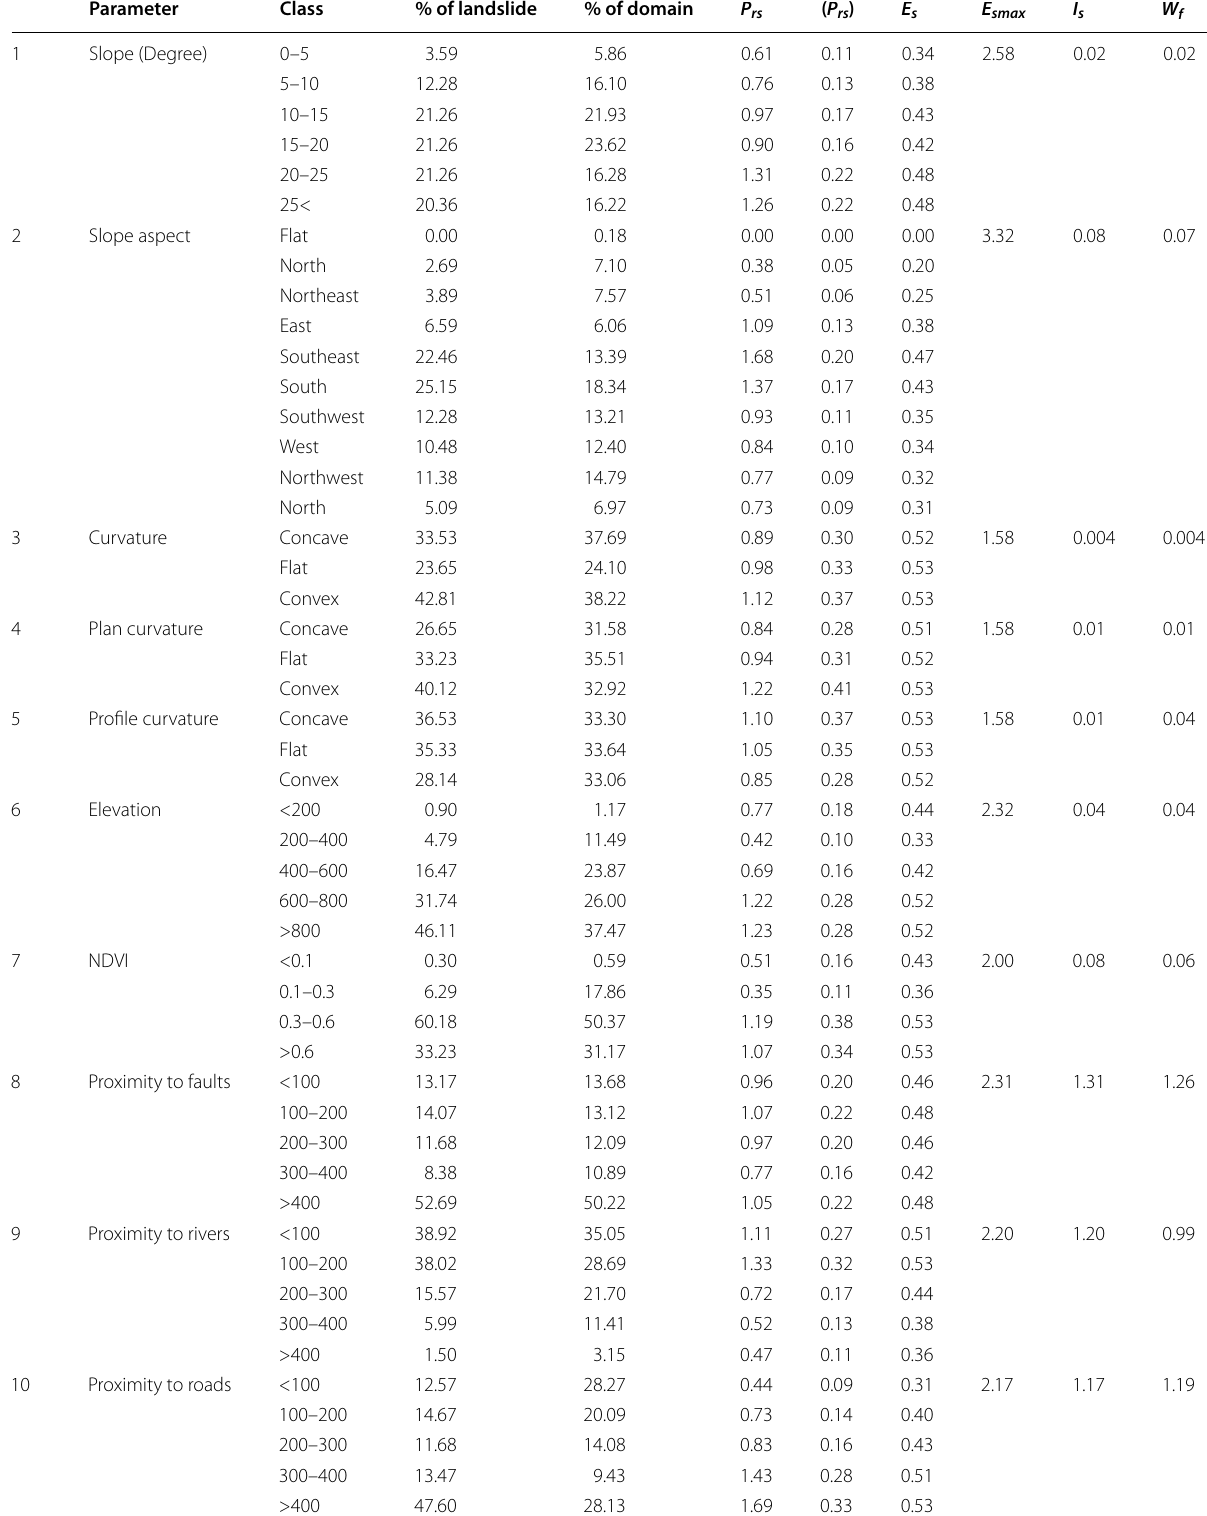
Table 4 Important factors for landslide susceptibility assessment in the study area with lower IoE value